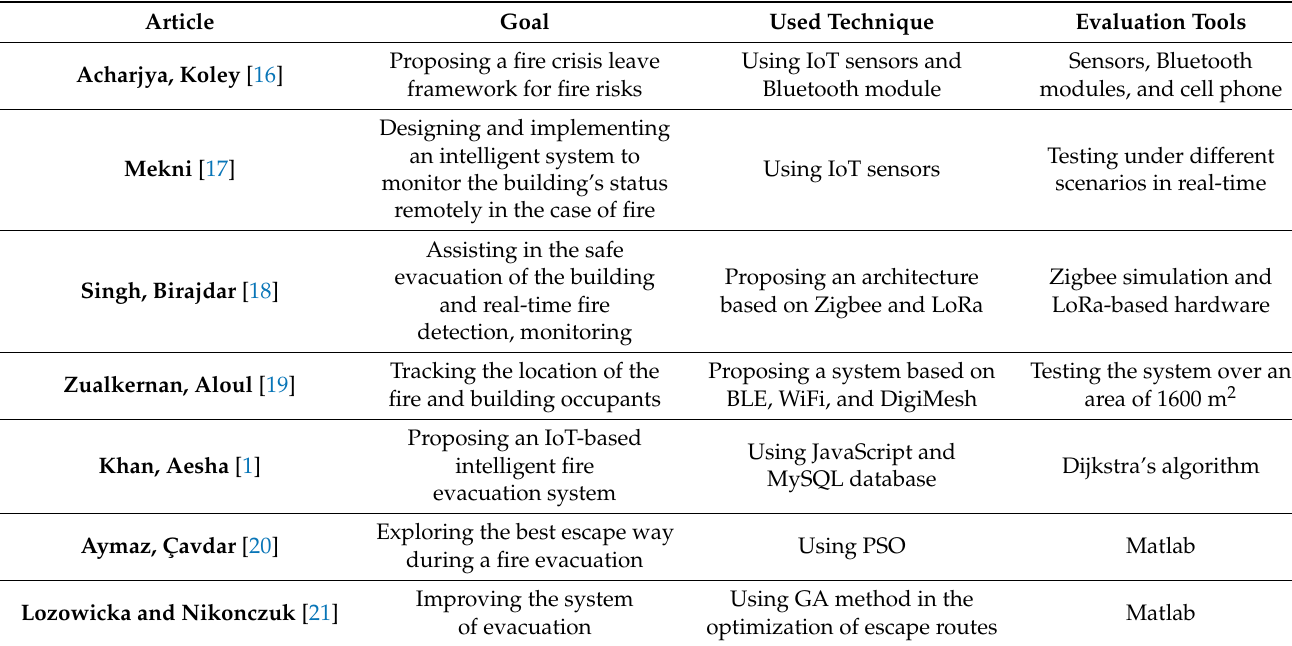
Table 1. Side-by-side comparison of the studied